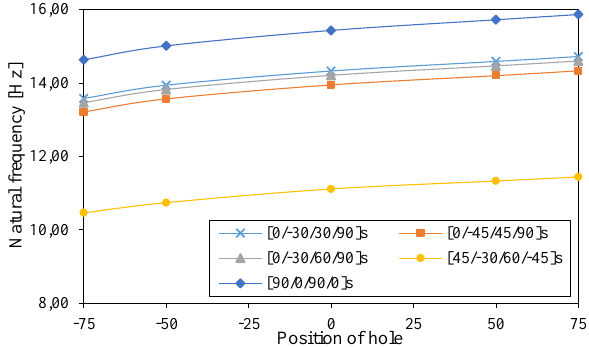
metric ratio (a/b = 1.0). While, the composite plate with